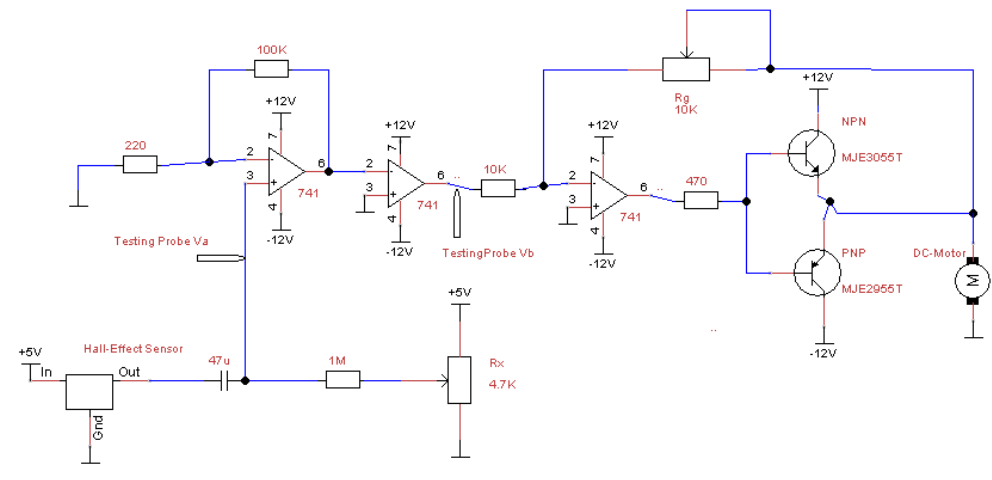
Figure 9. Electronic realization of the control scheme by employing opamps. Here, all electronic elements are in standard units. For instance, the resistor element 1 M represents a resistance of 1 M Ω , and the capacitor 47 µ a capacitance of 47 µ F, and so